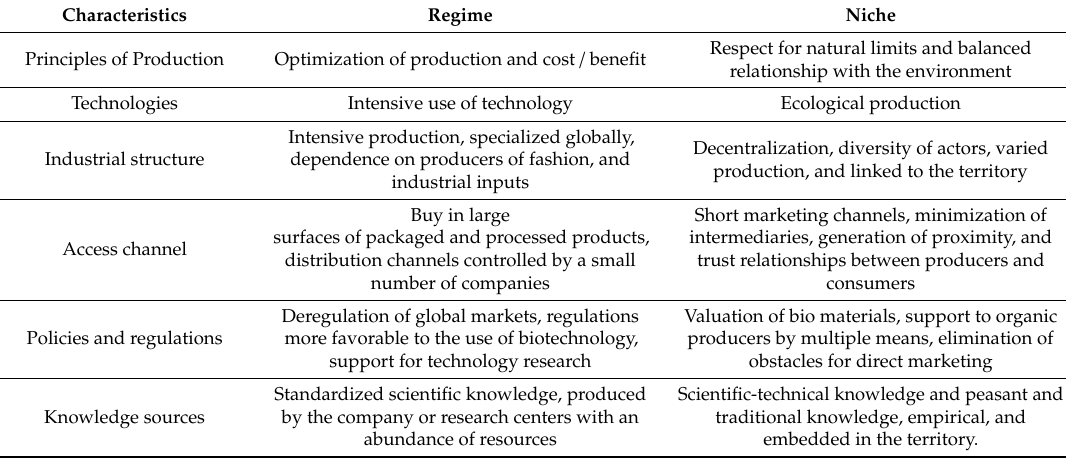
Table 1. Comparison between the niche and the